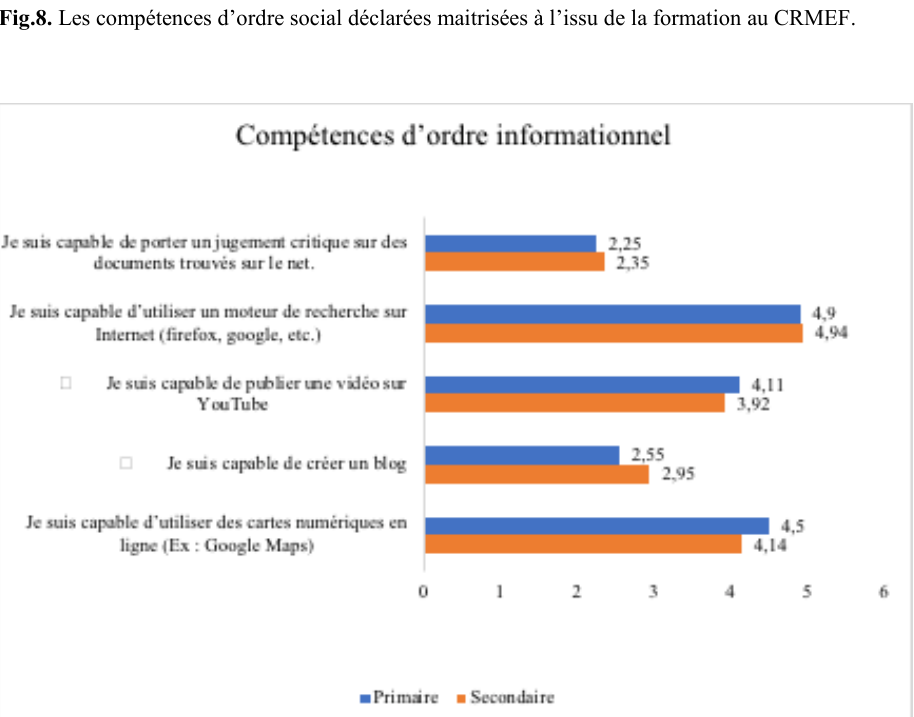
Fig. 7. Les compétences d’ordre épistémologique déclarées maitrisées à l’issu de la formation au CRMEF.